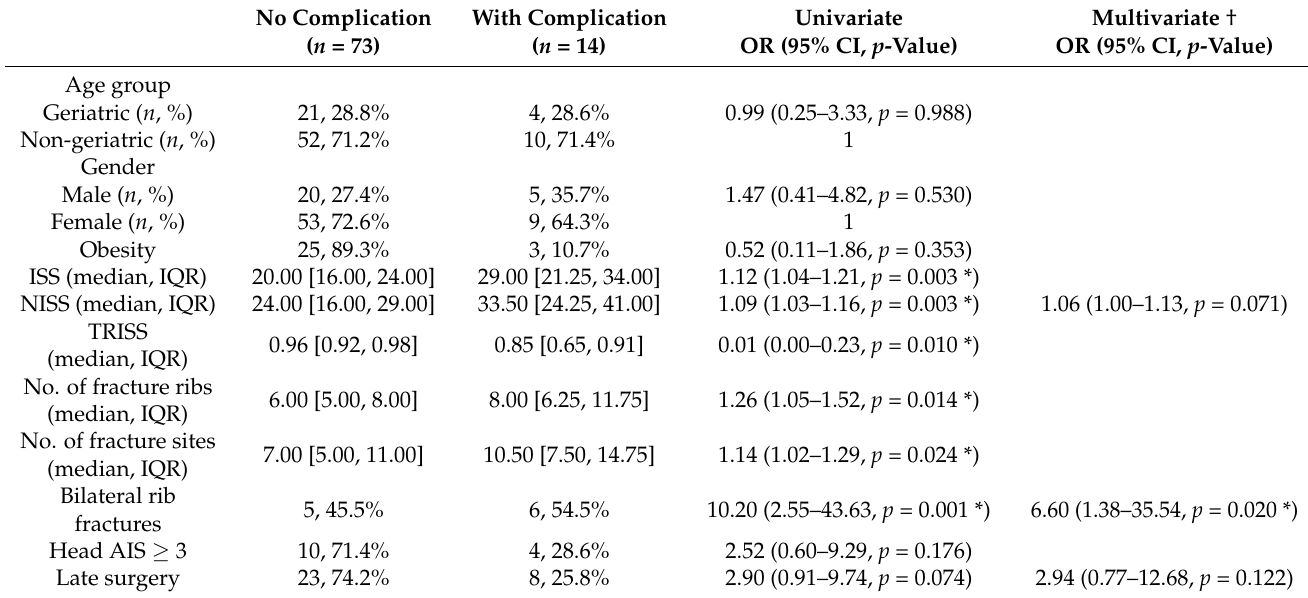
Table 3. The risk factors regarding complications with univariate and multivariate regression